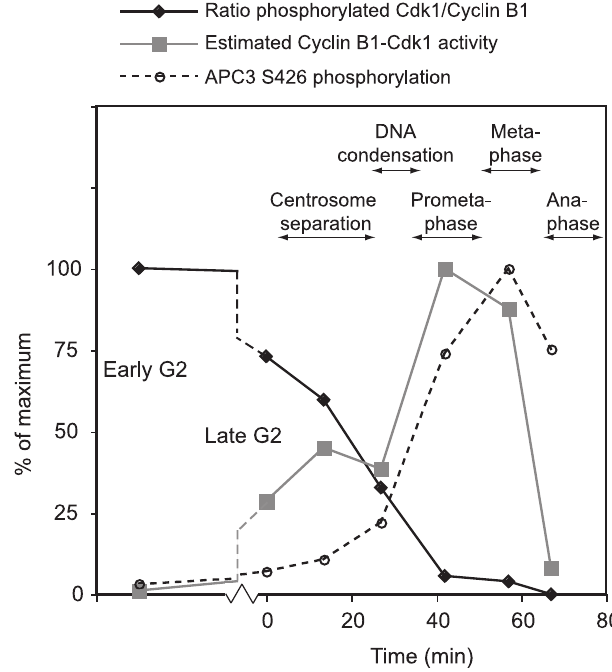
Figure 4. Schematic Representation of Cytoplasmic cyclin B1–Cdk1 Activation Average ratio of Cdk1-P and cyclin B1 staining (black solid line), average estimated cyclin B1–Cdk1 activity (gray solid line), and average APC-3 S426-P (black dotted line) plotted as a function of time ( x -axis). The duration of mitotic events is derived from measurements described in Figure S8. Note the decrease in total cytoplasmic activity, but not in the progression of cyclin B1–Cdk1 dephosphorylation, between centrosome separation and nuclear translocation of cyclin B1–Cdk1.